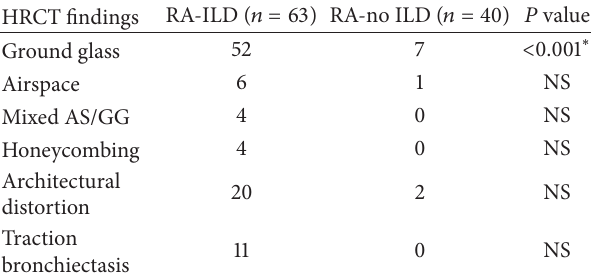
Table 2: Pulmonary function tests in RA-ILD and RA-no ILD. % of predicted